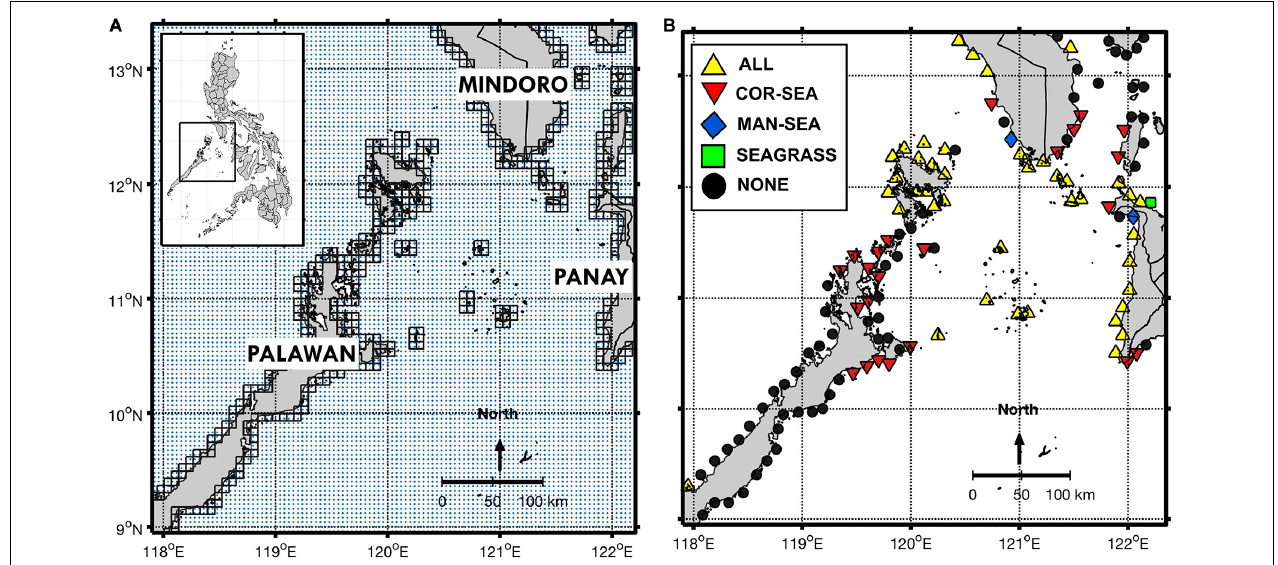
FIGURE 1 | (A) The model domain with three major islands labeled. Romblon Island is north of Panay between 12 ◦ N and 13 ◦ N, while southern Marinduque is visible to the east of Mindoro (uppermost right of the domain). Coastal release and settlement sites are outlined in black while blue dots correspond to the regional SEAc HYCOM model grid. (B) Summary of habitat presence per node based on satellite data. Coastlines were plotted using the publicly available m_map and m_gshhs packages (Pawlowicz, 2020) through MATLAB R2016a